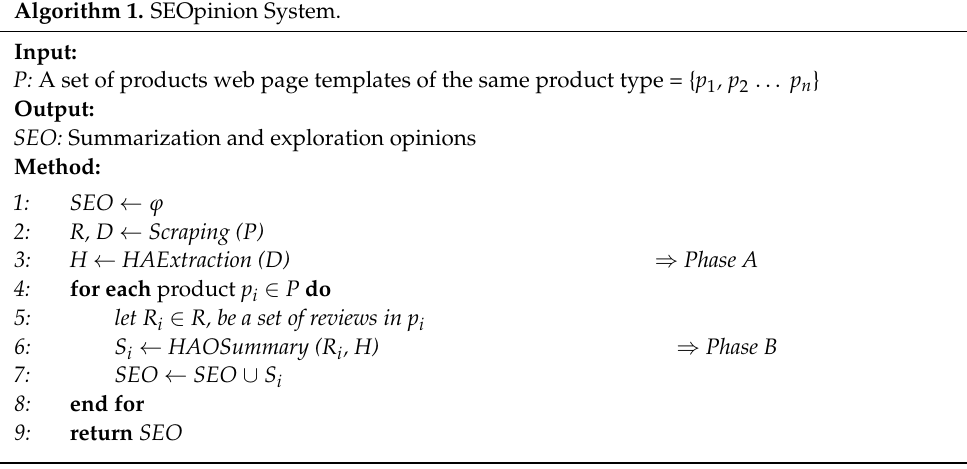
Figure 2. Overview of the SEOpinion system. Algorithm 1. SEOpinion